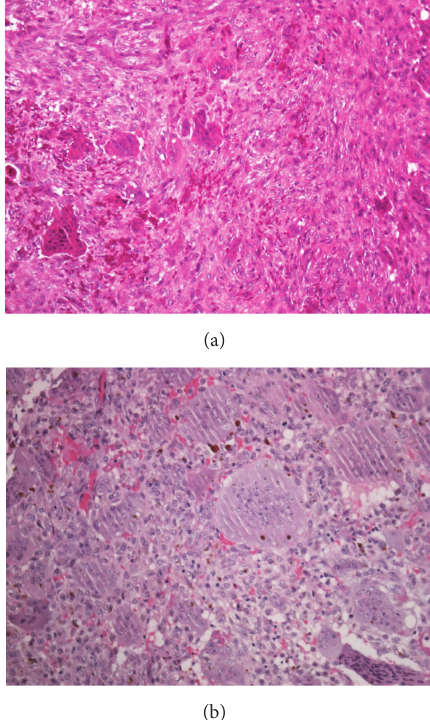
Figure 2: (a) Characteristic histology of giant cell tumor: mononu- clear cells with round to oval nuclei interspersed with numerous multinucleated giant cells. (b) Larger magnification of a typical multinucleated giant